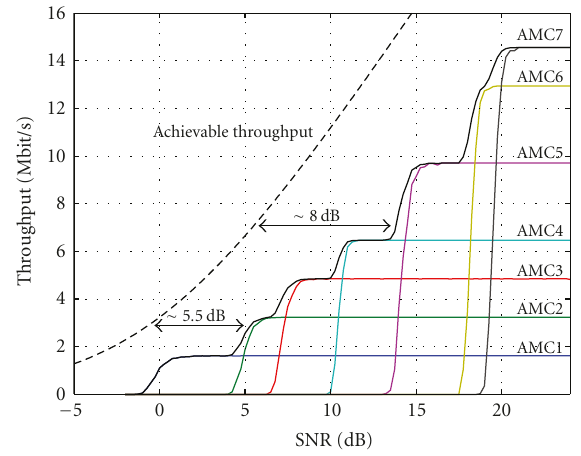
Figure 12: Simulated throughput performance of the SISO system with perfect channel knowledge in an AWGN channel.